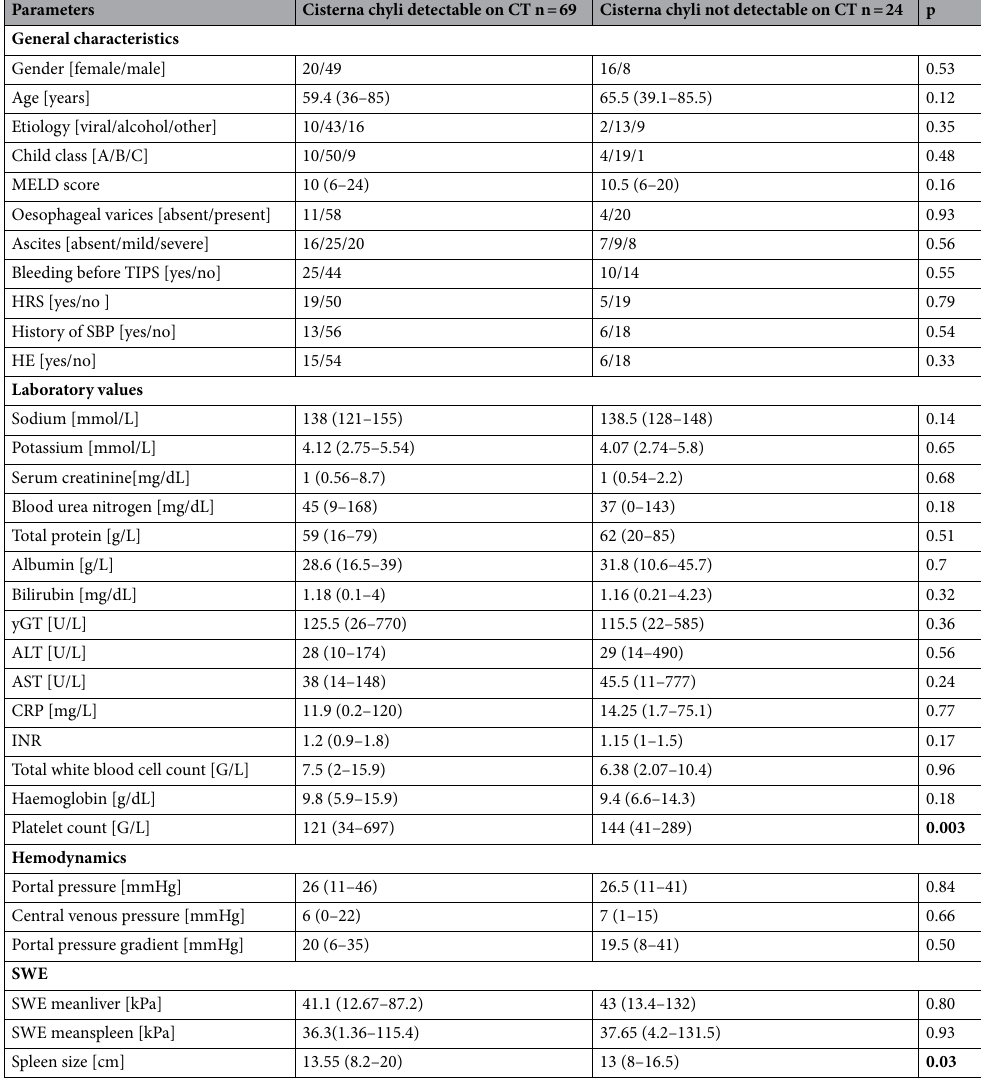
Table 2. Comparison of patients with and without a detectable cisterna chyli on CT. Statistically significant values (p < 0.05) are shown in bold.